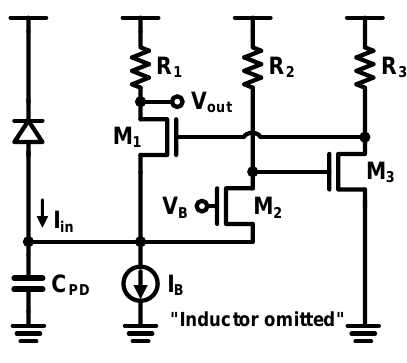
Figure 24. CG-feedforward TIA.